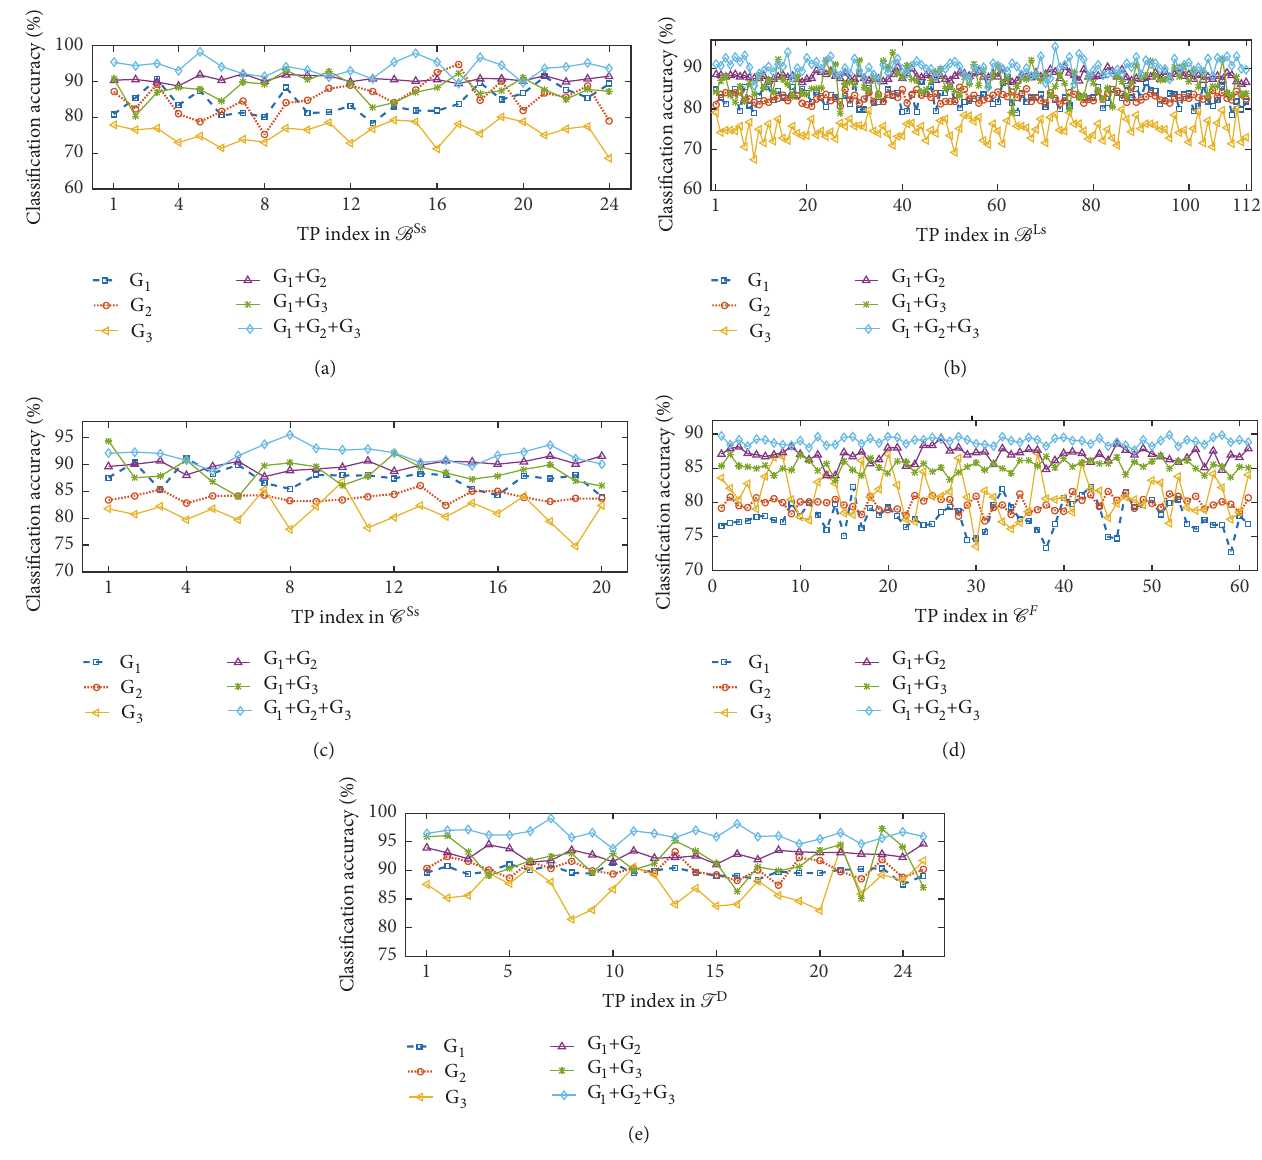
Figure 12: Classification accuracies based on